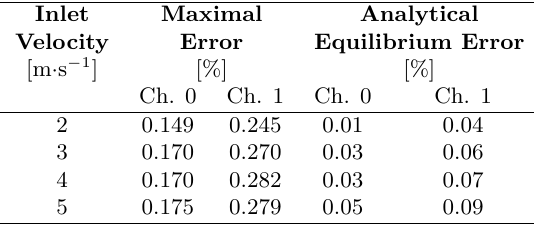
Table 1. Friction flow split comparison results. distribution is in great agreement with SubChanFlow calculation.